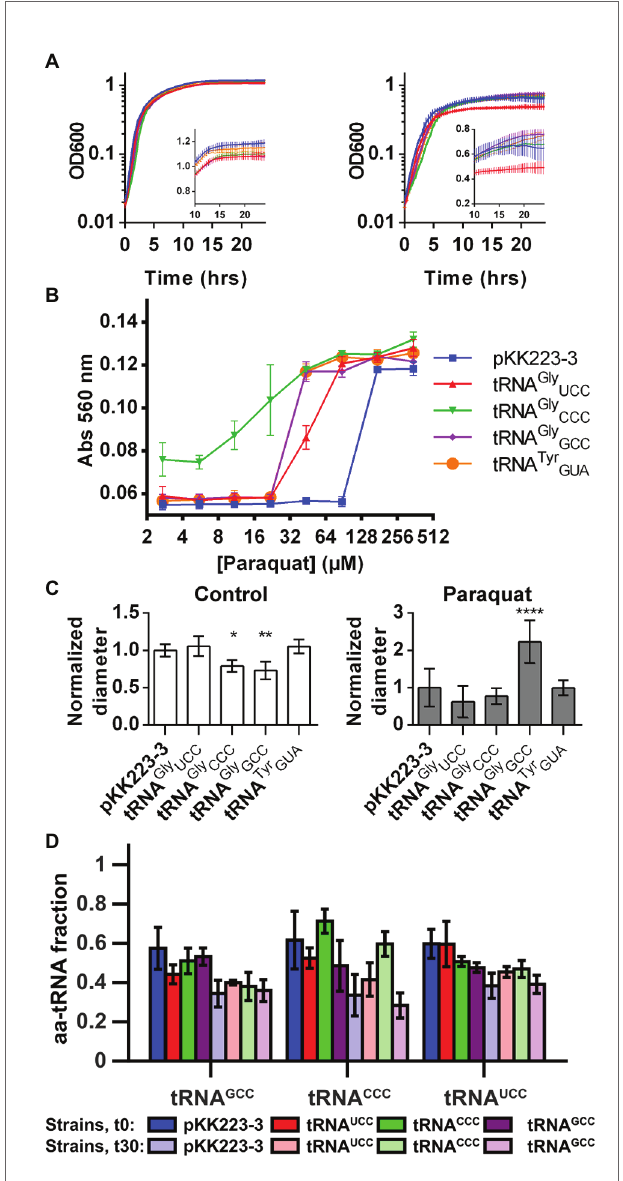
FIGURE 4 | Overproduction of tRNA Gly alters the response of E. coli to oxidative stress. The effect of overproduction of diverse tRNA Gly isoacceptors on the response to oxidative stress induced by paraquat was studied. (A) Effect of tRNA Gly overproduction over growth curves performed at 37 ° C in control media (left) or media with paraquat (stress condition, right). Inset graph shows same data in linear scale for time points above 10 h. tRNA Gly CCC : green, tRNA Gly GCC : purple, tRNA Gly UCC : red, tRNA Tyr GUA : orange, and empty pKK223-3 plasmid: blue ( n = 8). (B) Effect of tRNA Gly overproduction on the fermentation of lactose as measured by changes in media pH after incubation at diverse paraquat concentrations. Higher absorbance indicates higher pH (lower fermentation of the carbohydrate). tRNA Gly CCC : green inverted triangles, tRNA Gly GCC : purple rhombus, tRNA Gly UCC : red triangles, tRNA Tyr GUA : orange circles, and empty pKK223-3 plasmid: blue squares ( n = 3). (C) Effect of tRNA Gly overproduction on bacterial motility as measured by changes in the diameter of colonies cultured on low agar LB plates in the absence (left) or presence (right) of paraquat. Data in graph represent the diameter of colonies normalized dividing by the average diameter of the control colonies. Each bar